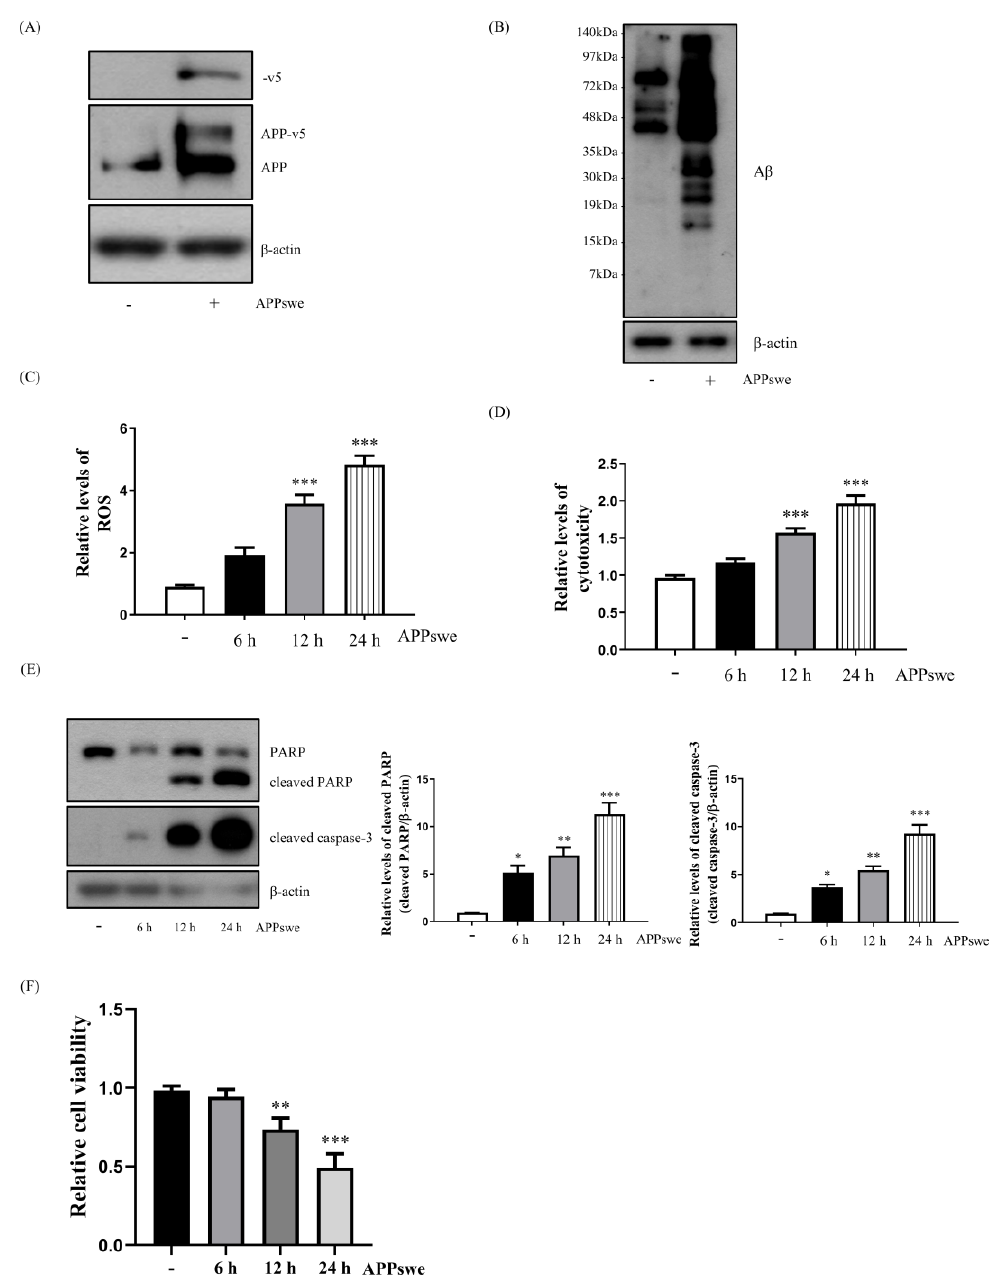
Figure 1. Amyloid-beta oligomer (A βO) accumulation increases the levels of reactive oxygen species (ROS), cytotoxicity, and cell death in N2a-APPswe cells. ( A ) Western blot analysis showing the APPswe gene’s exogenous transduction in the N2a and APPswe stably expressing N2a (N2a-APPswe) cells. ( B ) Amyloid-beta oligomer expression was evaluated by Western blot analysis in N2a and N2a-APPswe cells. ( C ) Flow cytometry analysis of intracellular ROS levels in N2a-APPswe cells cultured for 6, 12, and 24 h, measured using the fluorescent dye CM-H2 DCFDA (2.5 μM). ( D ) Lactate dehydrogenase (LDH) analysis of cytotoxicity in N2a-APPswe cells cultured for 6, 12, and 24 h. ( E ) Western blot analysis of poly (ADP-ribose), polymerase (PARP), and cleaved caspase-3 expression in N2a-APPswe cells cultured for 6, 12, and 24 h. ( F ) Cell viability was measured using a CCK cell viability assay kit for N2a-APPswe cells cultured for 6, 12, and 24 h. Data are represented as the means ± SEMs of three independent experiments (* p < 0.05, ** p < 0.01, and *** p <